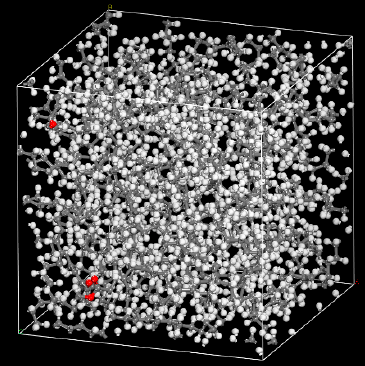
Figure 1. Amorphous cell of polyethylene (PE) and five flavor organic molecules. Table 1. Composition of the amorphous cells constructed.